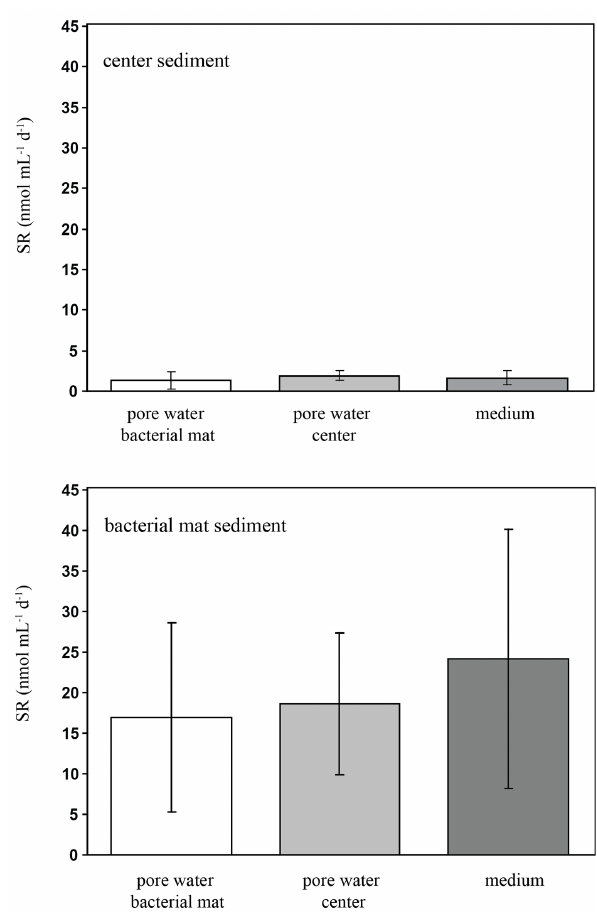
Fig. 7. SR inhibition experiment. Error bars indicate standard devi- ation ( N =